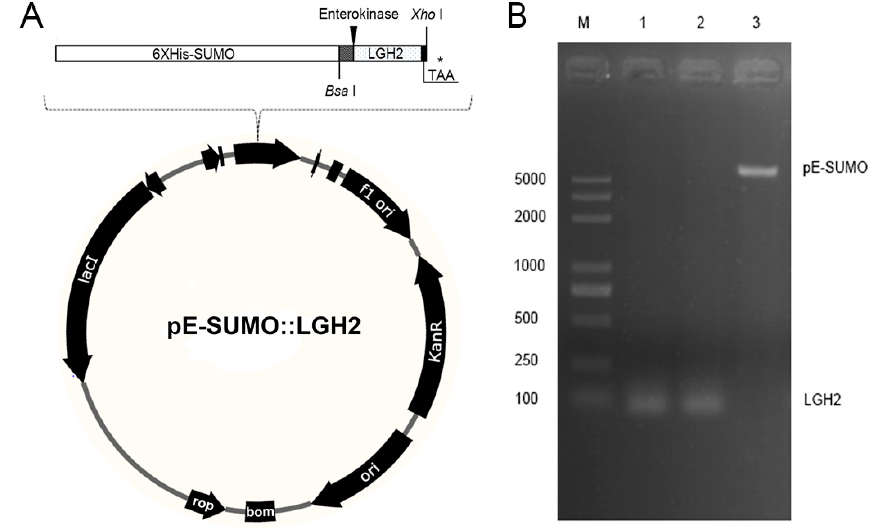
Figure 2. The construction of the expression vector. ( A ) Construction of pE-SUMO-LGH2 vector; * stands for termination codon. ( B ) Agarose gel electrophoresis of linearized pE-SUMO plasmid and LGH2 gene. Lane M was the DNA marker; Lane 1 was the PCR product amplified from the T4-LGH2 vector; Lane 2 was the enzymatic production by both Bsa I and Xho I; Lane 3 was the lyzed pE-SUMO vector by both Bsa I and Xho I.